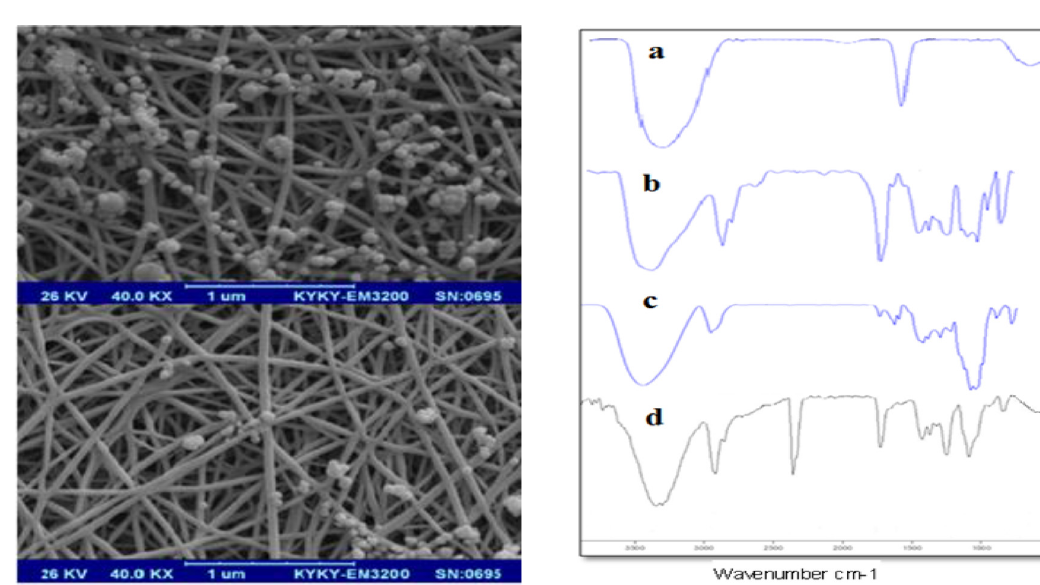
Fig. 4. FT-IR spectra (a) Fe3O4 nanoparticles, (b) PVA, (c) DOX, (d) DOX-loaded nanocarrier